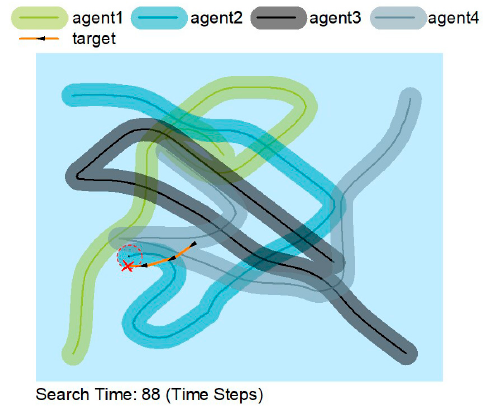
Figure 6. Search paths for the MADDPG algorithm.